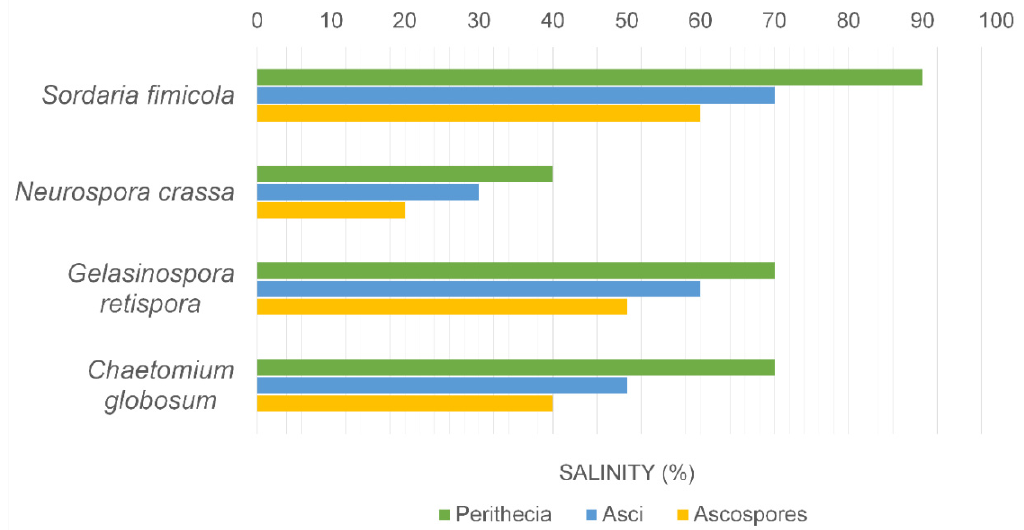
Figure 1. Effect of salinity on the production of perithecia, asci and ascospores of fungi.